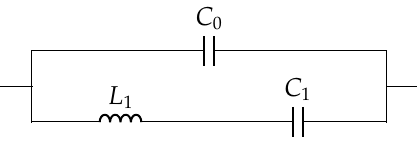
Figure 3. Sherrit model: unloaded